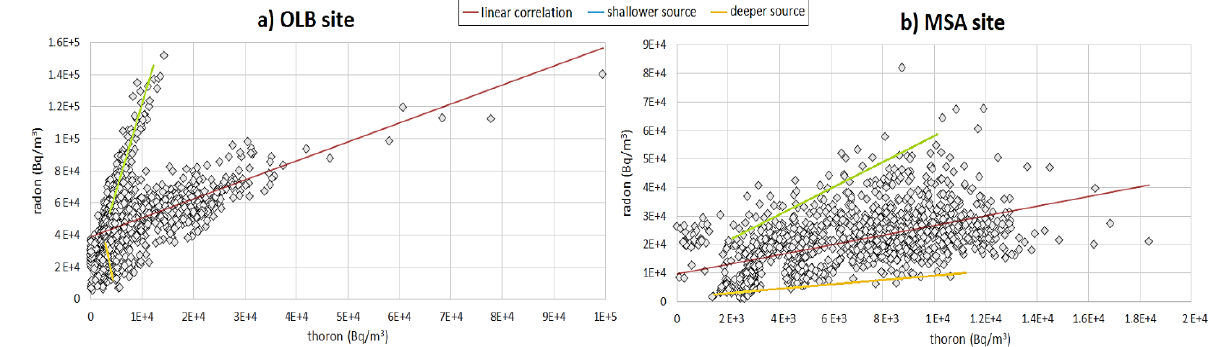
Figure 6. Activity concentration of 222 Rn (radon) vs. 220 Rn (thoron) at OLB ( a ) and MSA ( b ) sites during the monitoring period of 1 July 2011 – 31 December 2017. The red lines indicate a linear correlation between the two isotopes of the gas; the green and yellow lines indicate the different correlations for the parts of recorded data that should come from shallow and deep sources, respectively [62].